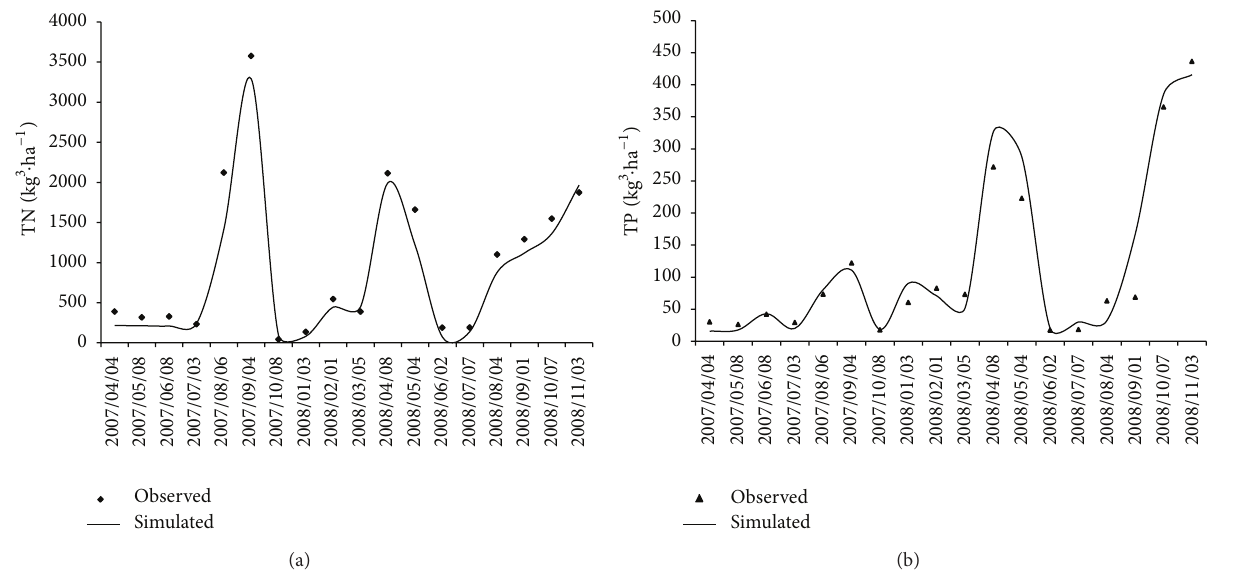
Figure 4: Time series of simulated and observed daily TN and TP from 2007 to 2009 at the JG station in the Dong basin.